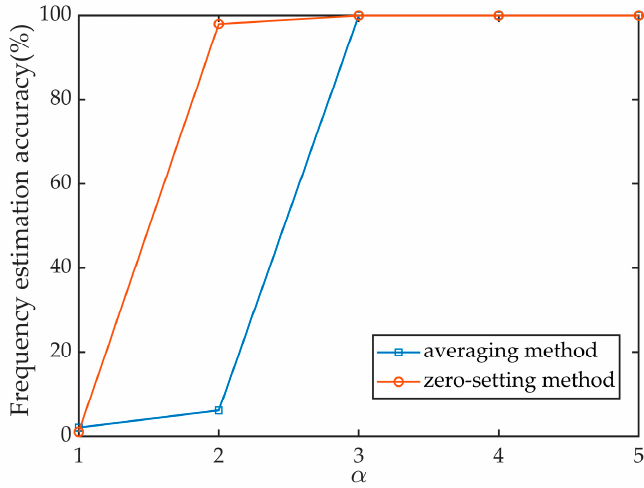
Figure 9. The effect of α on the frequency estimation accuracy. consistent with the phenomenon mentioned in Section 3.3. When α = 3, the frequency estimation accuracy is 100% for both the averaging method and the zero-setting method. Therefore, in the subsequent simulations, the parameter α was set to 3, and the zero-setting method was chosen to process p